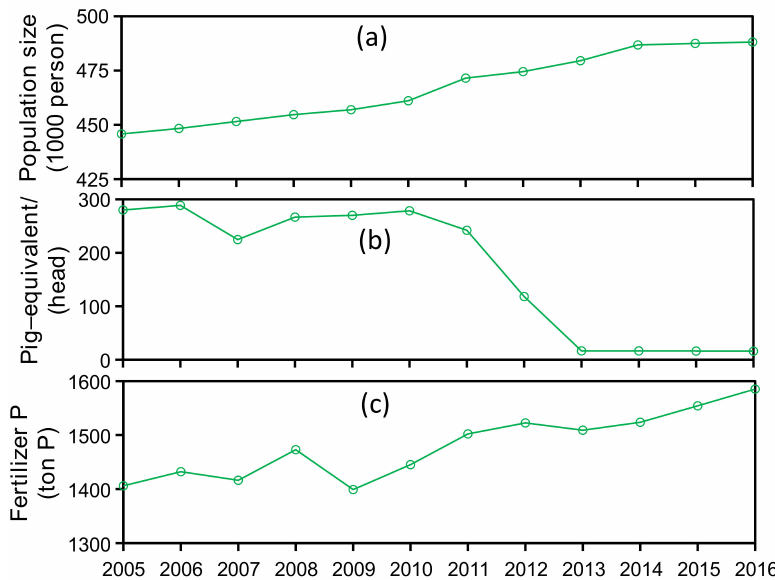
Figure 2. Annual ( a ) population size, ( b ) livestock production, and ( c ) P fertilizer application amount within Shanxi Drinking-Water Source Area (SDWSA). Livestock production is transformed to pig-equivalent values (1 pig equals 45 poultry, 30 rabbits, 3 sheep, and 0.2 cattle, respectively) according to Discharge Standard of Pollutants for Livestock and Poultry Breeding (GB18596-2001).